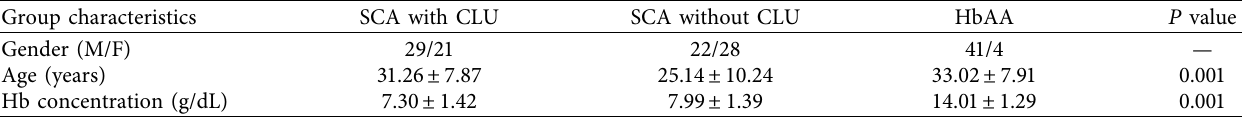
Table 1: General characteristics of study participants.